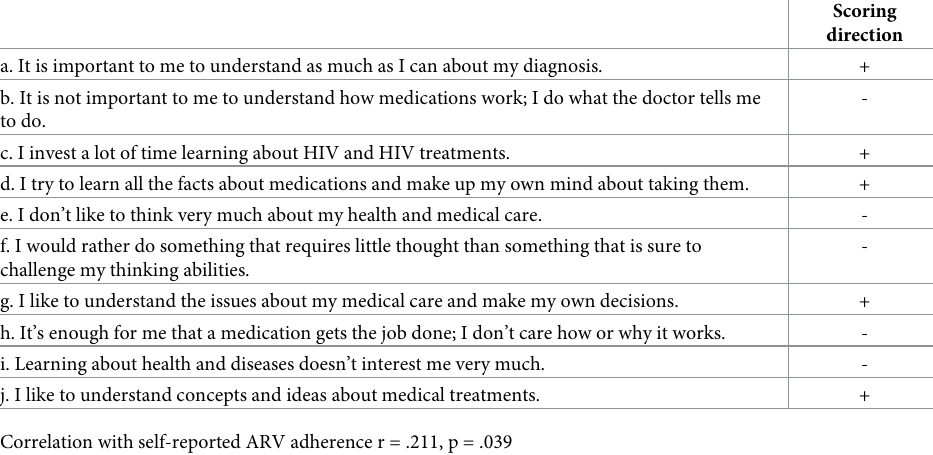
Table 4. Adapted need for cognition scale.